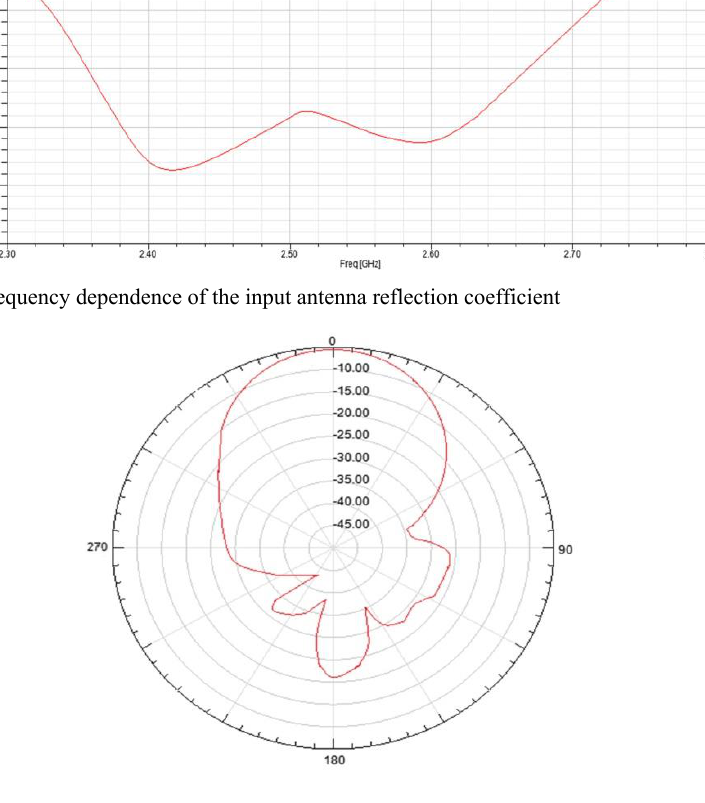
Fig. 8. The radiation pattern of the antenna in the plane